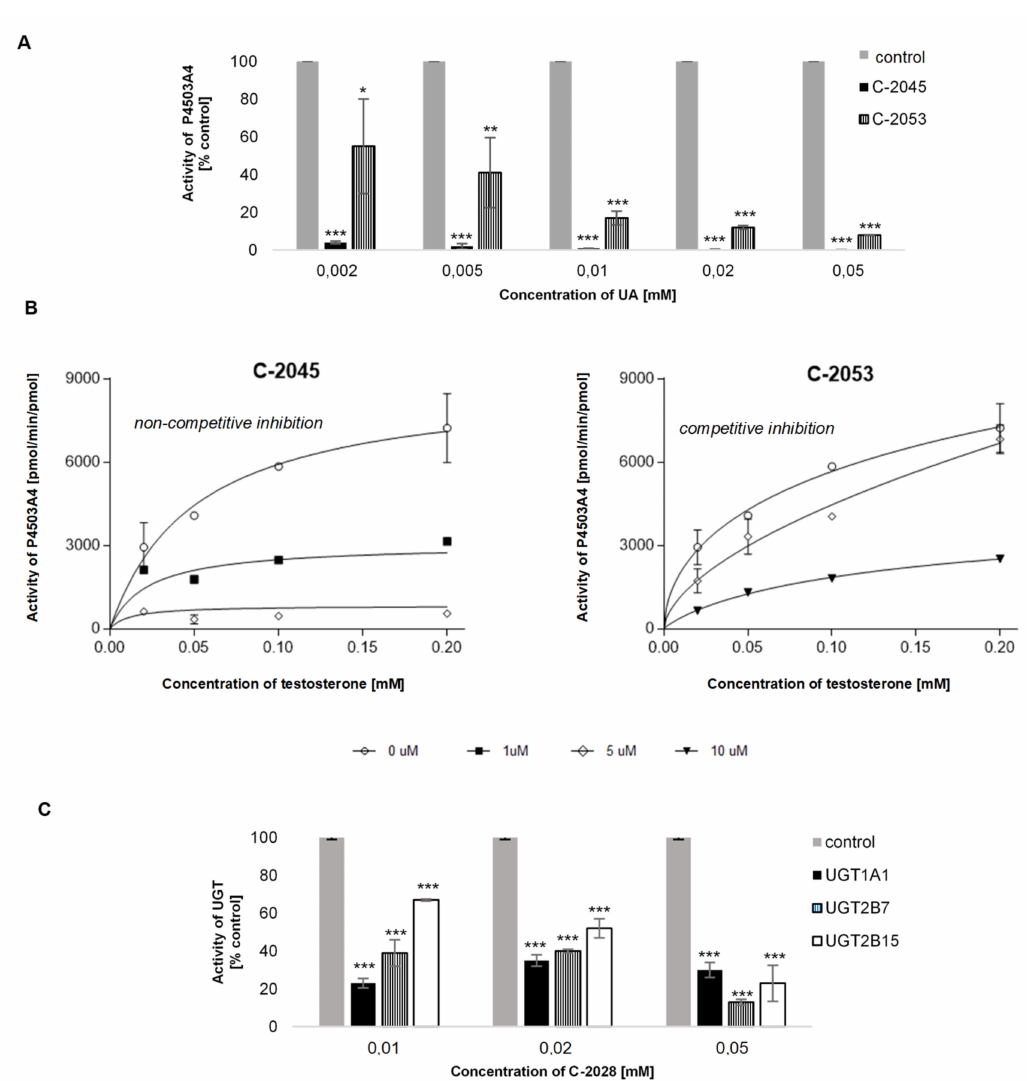
Figure 12. The effect of UAs concentration on P4503A4 and UGT activity. The modulation of: ( A,B ) testosterone β -hydroxylation with P4503A4 by C-2045 and C-2053 ( C ) glucuronidation activity of human recombinant UGT isoen- zymes studied with the specific substrates: SN-38 for UGT1A1, epirubicin for UGT2B7 and TFK for UGT2B15 by C-2028. Values are expressed as the mean ± SD of duplicate experiments. Enzymatic activities towards standard substrates in the absence of UAs were normalized to 100%. Comparisons were made using one-way ANOVA, followed by Bonferroni’s multiple comparisons test, or an unpaired t -test. Levels were considered significant at * p < 0.05; ** p < 0.01; *** p <